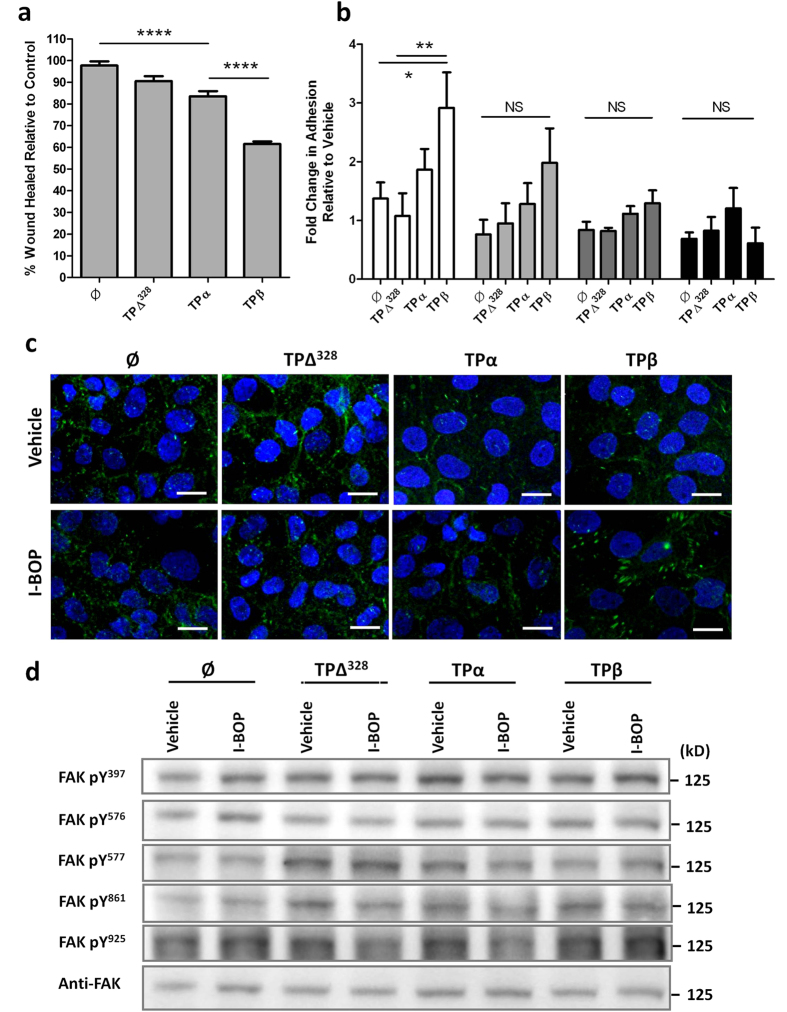
Migration of trophoblast cells is attenuated by TPβ activation.(a) Motility of transfected JEG-3 cells in response to I-BOP (200 nM) was investigated in a chemokinesis assay over 48 hours and compared to vehicle control. The distance the cells moved was analysed using TScratch software and expressed as a percentage wound closure, n = 6. (b) Adhesion of transfected JEG-3 cells, pre-treated with 200 nM I-BOP for 24 hours, to different extracellular matrix proteins (collagen I, □; collagen IV, ; fibronectin, ; vitronectin, ■) was assessed over a 30 minute period and compared to vehicle control. Attachment was quantified using methylene blue staining. (c) Transfected JEG-3 cells, treated with vehicle or 200 nM I-BOP, were stained with anti-vinculin antibodies and imaged at 400x magnification via fluorescence microscopy to identify focal adhesions. Scale bar: 20 μm. (d) Changes in FAK activation/phosphorylation at specific residues was measured via immunoblotting in transfected JEG-3 cells treated with vehicle or 200nM I-BOP. Loading was determined by re-probing the membranes with non-phosphorylated FAK and protein bands were quantified using densitometry. The data are represented as mean ± SEM and are representative of 3 independent experiments. One-way ANOVA, NS: not significant, *P < 0.05, **P ≤ 0.01, ****P < 0.001.